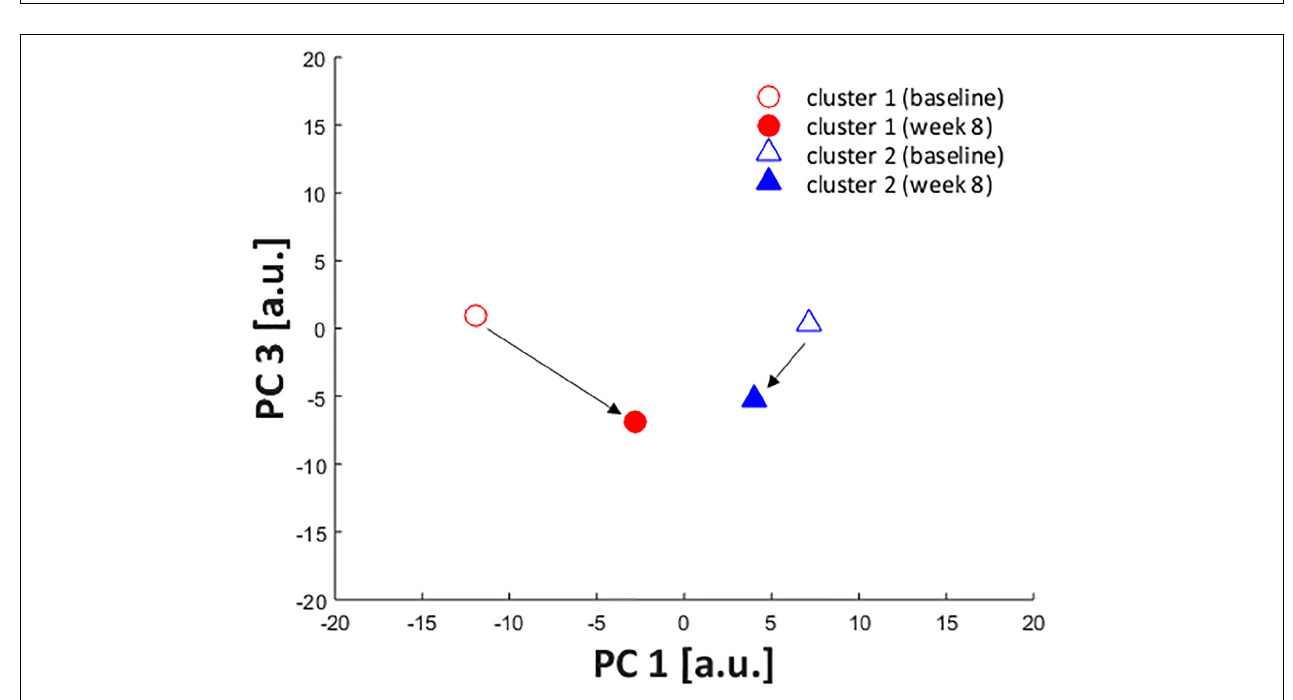
FIGURE 8 | Foot segment joint angles across clusters during stance phase of running, before (baseline) and after the intervention protocol (week-8). Runners from cluster 1 are represented at baseline by the red solid lines and at week-8 by the red dashed lines. Runners from cluster 2 are represented at baseline by the blue solid lines and at week-8 by the blue dashed lines.